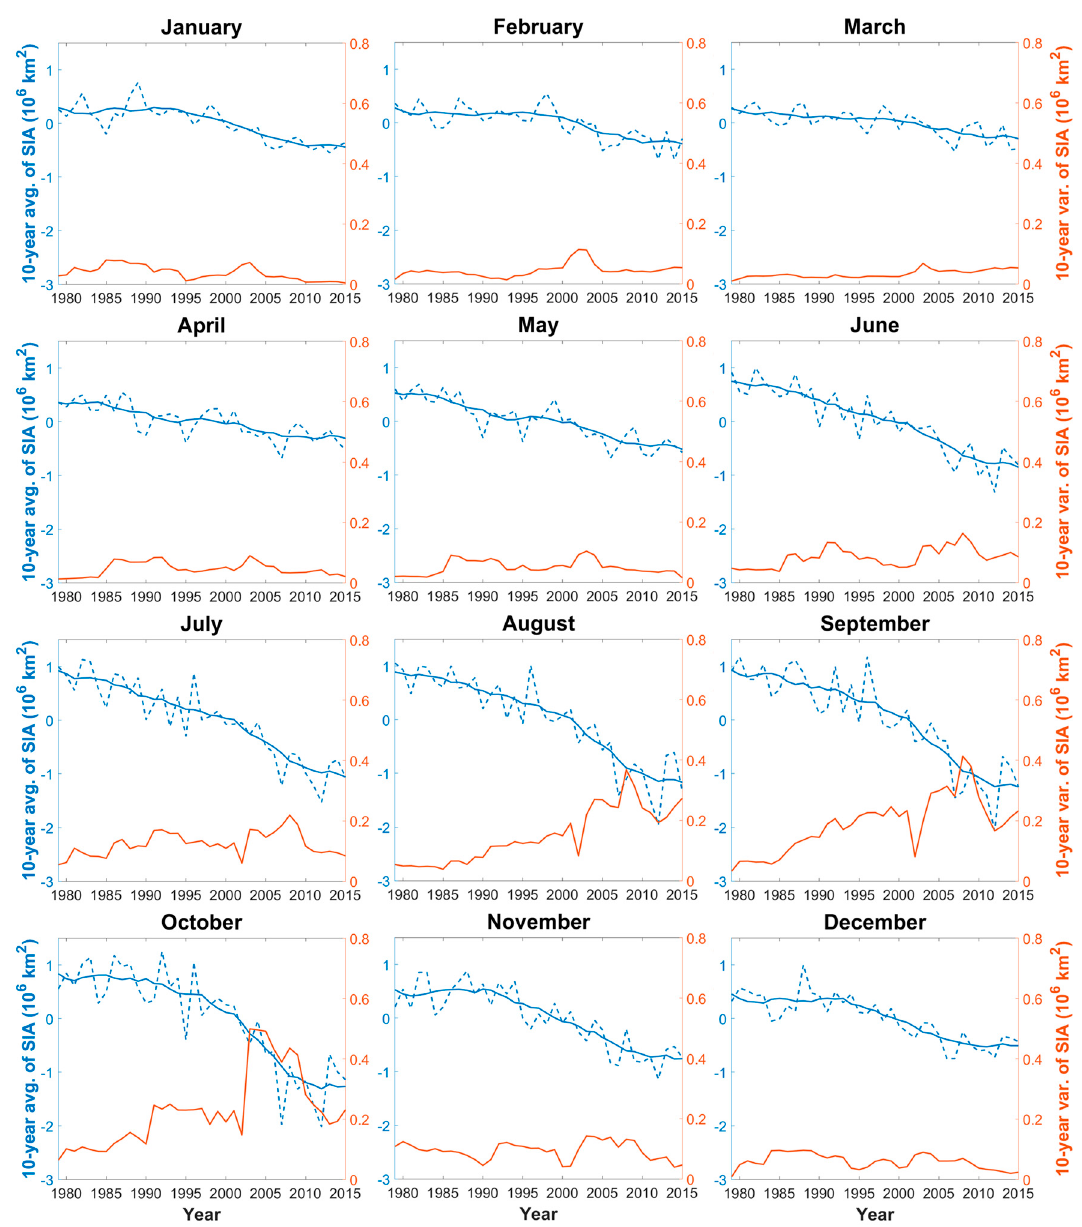
Figure 6. The 10-year moving mean (blue solid line) and variability (orange solid line) of sea ice anomalies (SIAs; blue dotted line) from 1979 to 2015.